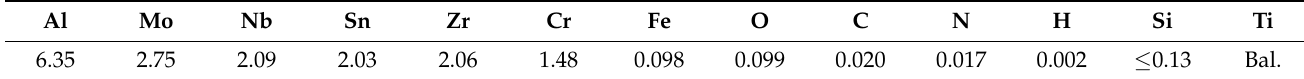
Table 1. Chemical composition of TC21 alloy, wt.%.